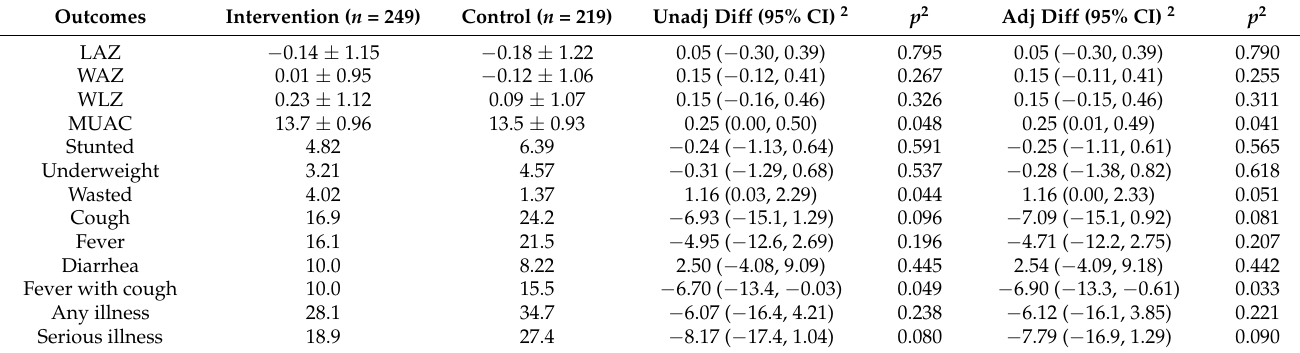
Table 3. Infant anthropometry and morbidity outcomes by study arms at 6 months postpartum follow-up 1